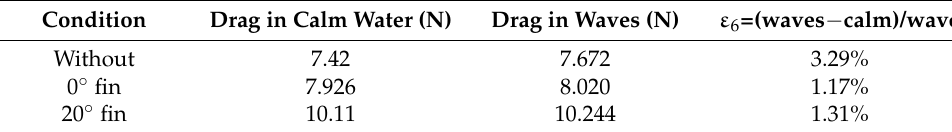
Table 8. Fin drag analysis at 20° in model scale (unit: N). Fr = 0.204.